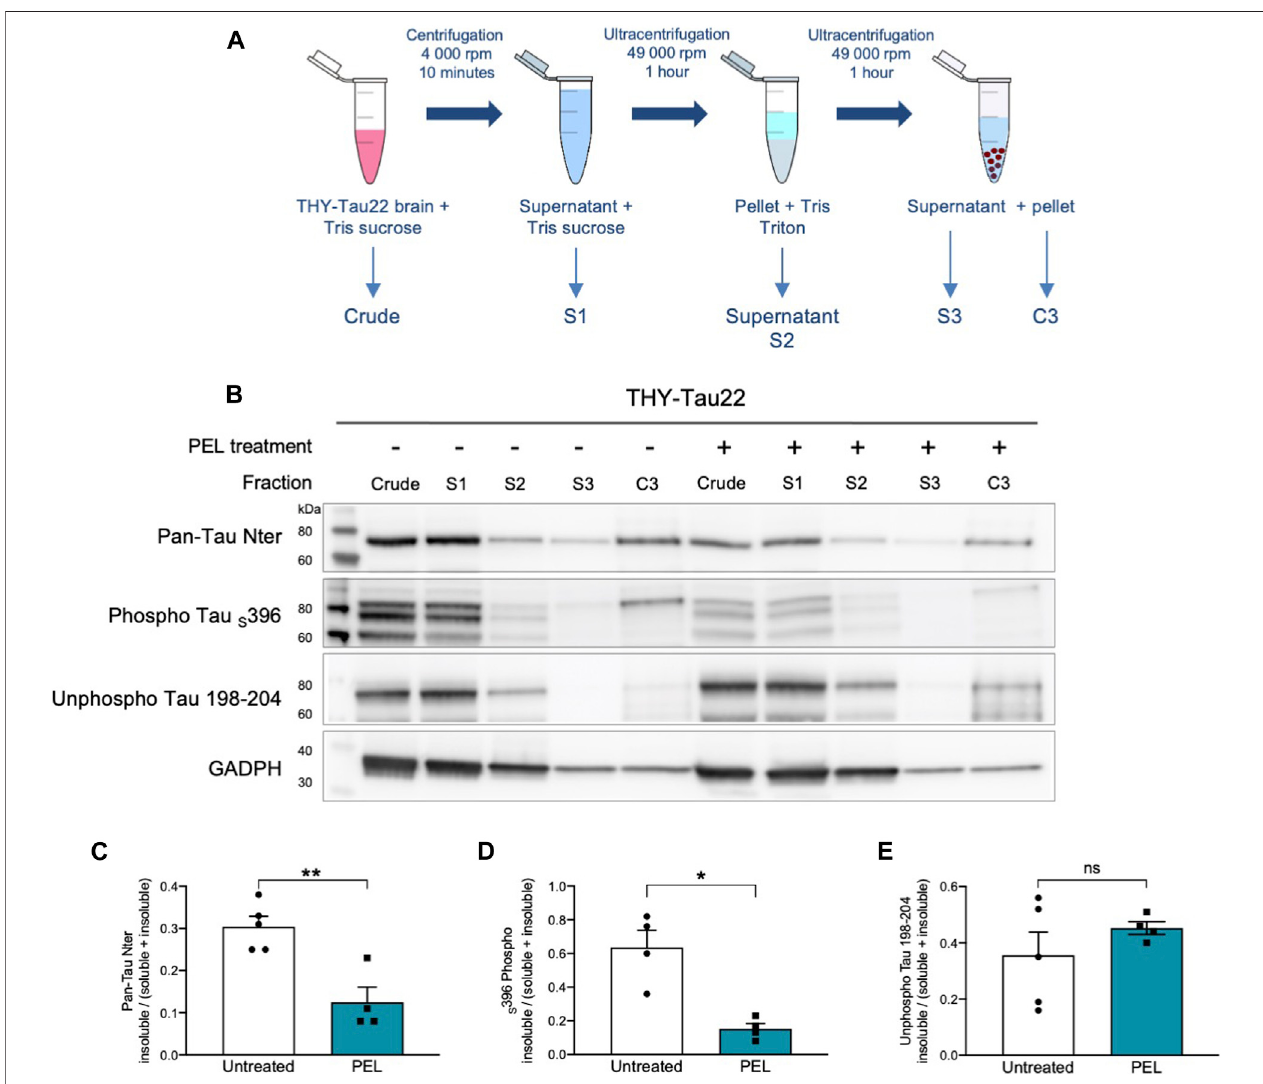
FIGURE 3 | PEL24-199 treatment decreases the insoluble phosphorylated tau fraction in THY-Tau22 mice. (A) Schematic representation of mouse brain tissue fractionation steps. The samples in TSB (Crude) are centrifuged, and the supernatant is added with 10% TSB (S1), and sonicated before being centrifuged at 100,000 × g.Thesupernatantiscollected(S2),andthepelletisresuspendedinTris-TritonX-100buffer,sonicated,andspunat100,000 × gfor1 h.Thesupernatant(S3) is collected, and the pellet is resuspended in SDS-PAGE LDS lysis buffer (C3). Each of the fraction from S1 to C3 and the crude brain lysate are loaded onto SDS- PAGE. (B) Westernblotoftau proteins (Pan-Tau Nter), phosphorylatedtau proteins at serine396 (Phospho Tau S 396), and unphosphorylated tauproteins (Unphospho Tau198-204)incrude,S1toS3andinsolubleC3pelletsfromthehippocampusofTHY-Tau22 – untreated( − )orPEL-treated(+)mice.GAPDHstainingwasperformedto ascertain that an equal quantity of material was loaded between untreated and treated protein fractions. (C,D, E) Histogram representations of the mean ± SEM ratio between the signal of the insoluble fraction divided by the signal in the soluble plus insoluble fraction for Pan-Tau Nter, phospho Tau S 396, and unphosphorylated Tau 198-04 antibodies labeling in the hippocampus fractions S1 (soluble) and insoluble (C3) of THY-Tau22 treated or not with PEL24-199 ( n (cid:1) 5 for untreated and n (cid:1) 4 for PEL treated animals). The mean difference was statistically considered as signi fi cant with a p -value below 0.05 (indicated by one asterisk).